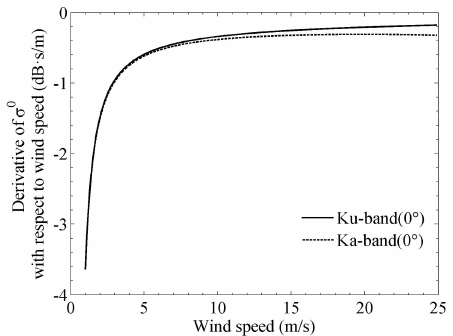
Figure 19. The derivative of σ 0 with respect to wind speed at 0 ◦ incidence angle as functions of wind